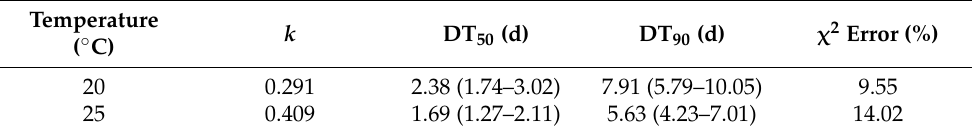
Table 4. Degradation kinetics parameter ( k ), DT x values, and χ 2 error for glyphosate fitted with the single first-order model in soil at 20 ◦ C and 25 ◦